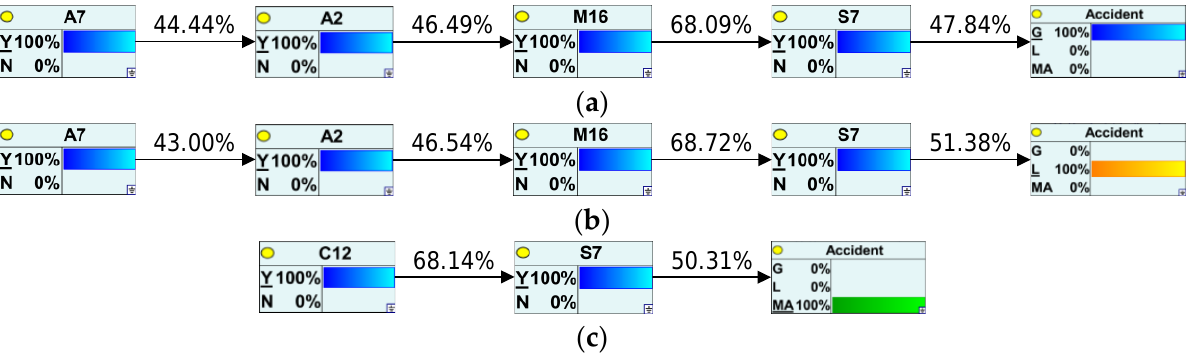
Figure 14. Key cause paths of different types of accidents. ( a ) The key cause path of general accidents. ( b ) The key cause path of larger accidents. ( c ) The key cause path of major and above accidents.